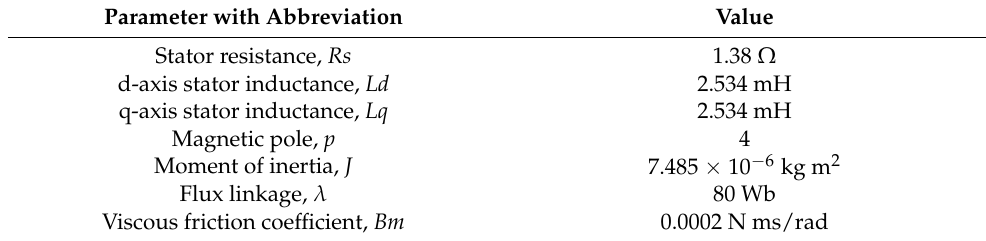
Table 1. Parameters of the